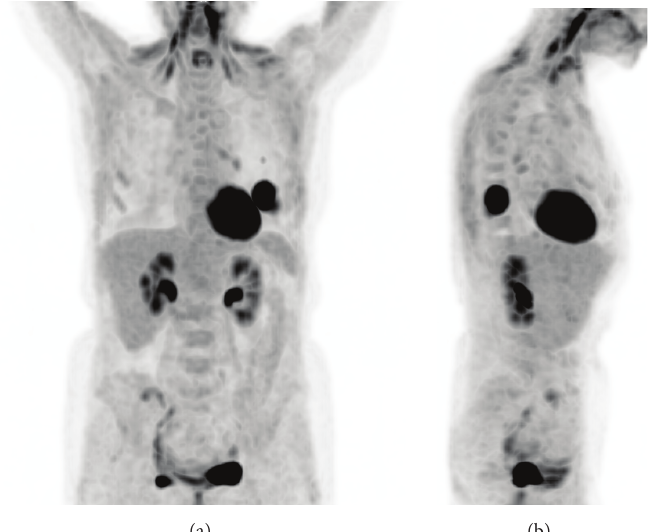
Figure 1: Coronal and lateral maximum intensity projection (MIP) images of the PET showing intensely FDG avid left lung mass and associated left hilar lymphadenopathy.